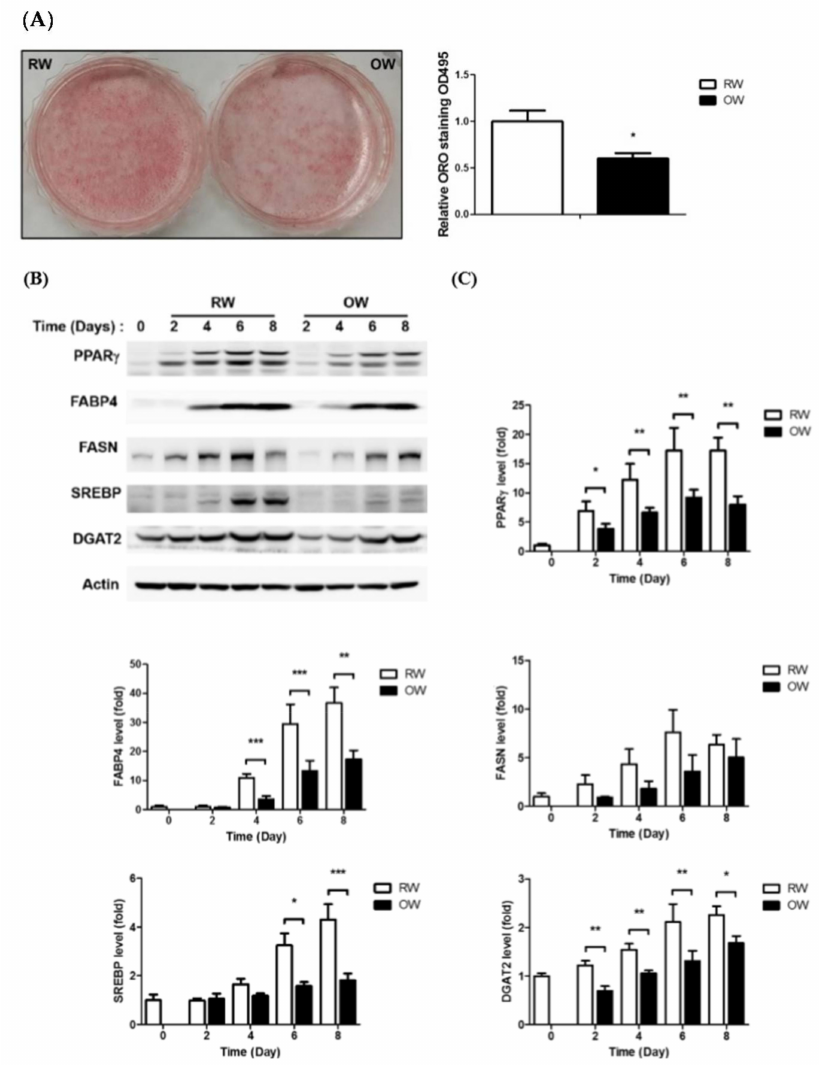
Figure 1. Oxygenated water inhibits adipocyte di ff erentiation. 3T3-L1 cells were allowed to undergo di ff erentiation in culture media with either regular water (RW) or oxygenated water (OW). ( A ) Lipid accumulation in 3T3-L1 mature adipocytes was evaluated and quantified by ORO staining. Data are expressed as mean ± S.E.M. ( n = 3), * p < 0.05. ( B ) Levels of major proteins involved in adipocyte di ff erentiation and lipid metabolism during di ff erentiation were analyzed by Western blotting and are quantified in ( C ). Data are presented as mean ± S.E.M. ( n = 4) and were statistically analyzed by two-tailed unpaired Student t-tests; * p < 0.05, ** p < 0.01, *** p < 0.001 (OW vs. RW). In addition, the protein levels of the central adipogenesis-driving transcription factor peroxisome proliferator-activated receptor-gamma (PPAR γ ) and adipocyte-specific marker fatty acid-binding protein 4 (FABP4) were significantly inhibited in cells under OW exposure. Critical lipid-synthesizing enzymes—including fatty acid synthase (FASN), sterol regulatory element-binding transcription factor 1 (SREBP) and diacylglycerol O-acyltransferase 2 (DGAT2)—were also down-regulated (Figure 1B,C). The above results indicate that OW significantly suppresses adipogenesis by down-regulating the expression of the critical transcription factor PPAR γ , adipocyte-specific FABP4 and lipid-synthesizing enzymes required for lipid